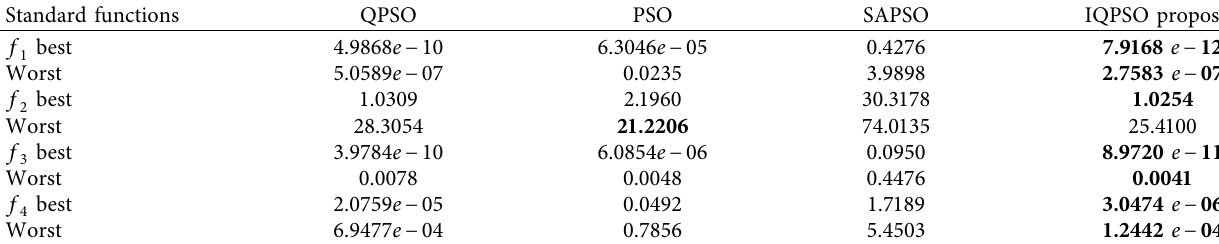
Table 3: The optimal results.